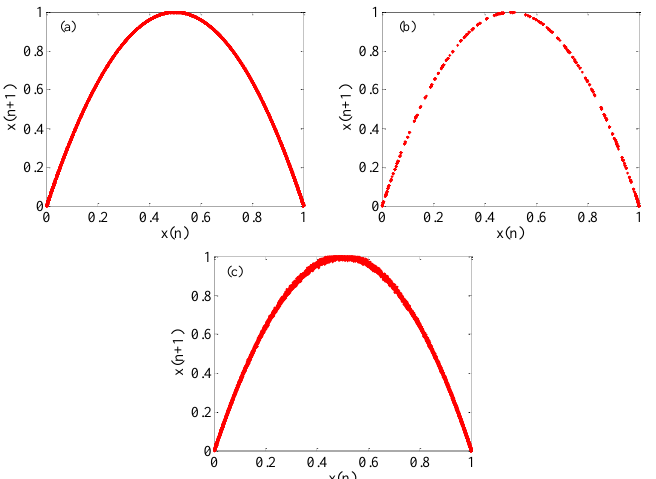
Figure 10. Comparison of chaotic attractors. ( a ) The original logistic map; ( b ) The logistic map of getting stuck in cycles; ( c ) The enhanced logistic